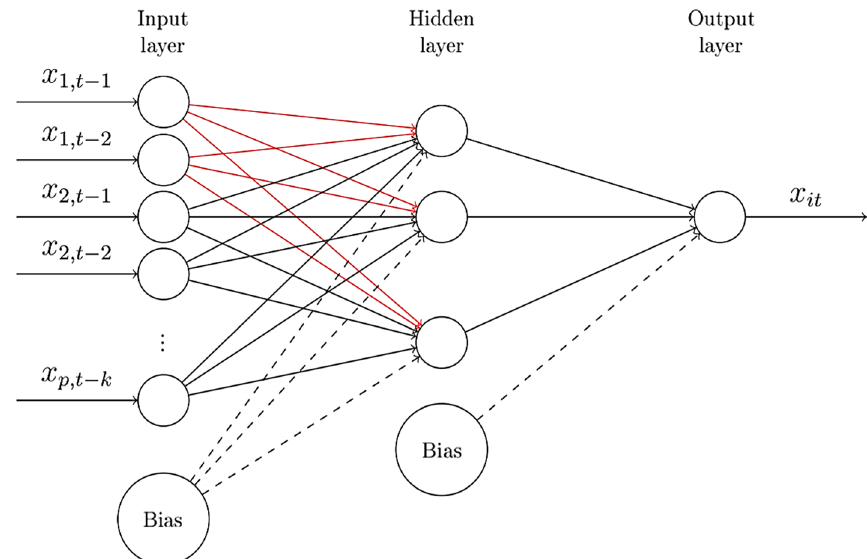
Fig. 1 Feed-forward neural network nonlinear Granger causality. Reference : Calvo-Pardo et al.